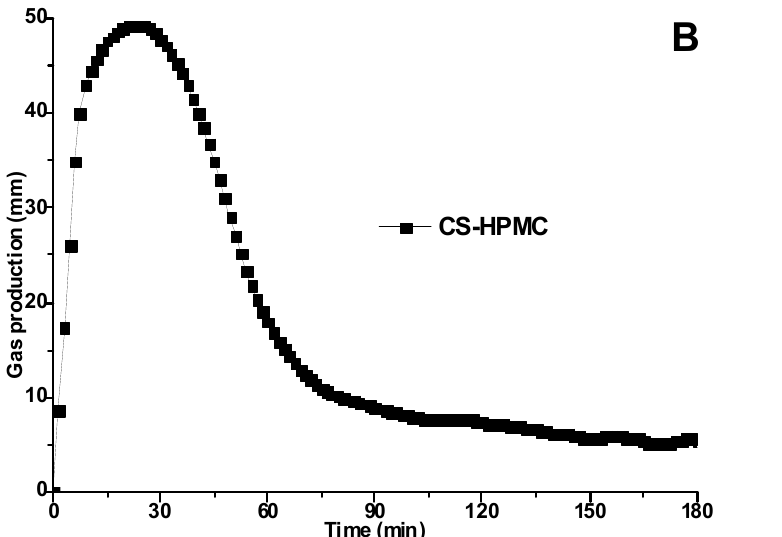
Figure 1. Proofing curves of the CS–HPMC gluten-free dough. Dough height ( A ) and gas production kinetics ( B ).